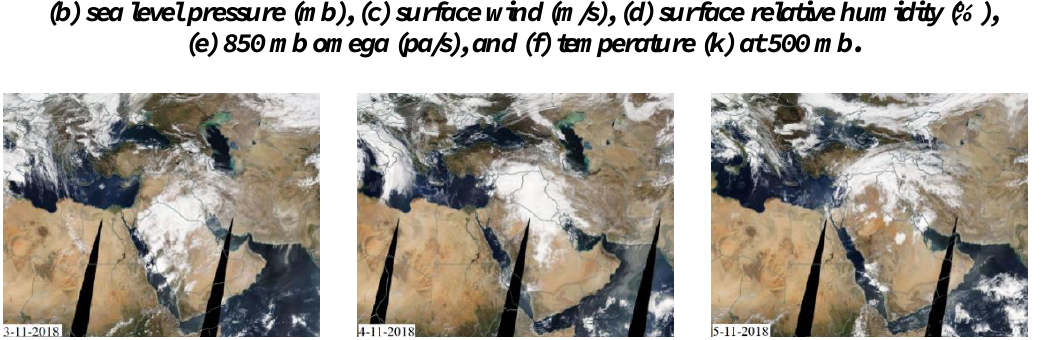
Figure 7: The satellite images illustrate the cloud over Iraq during the period (3-5 November